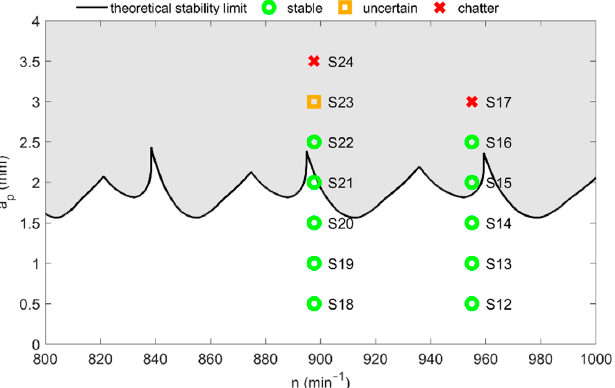
Figure 6. Stability lobe diagram for the slender end mill Iscar E90AN based on measured FRF and compared with machining stability tests: overhang L = 30 mm (Experiment 2).